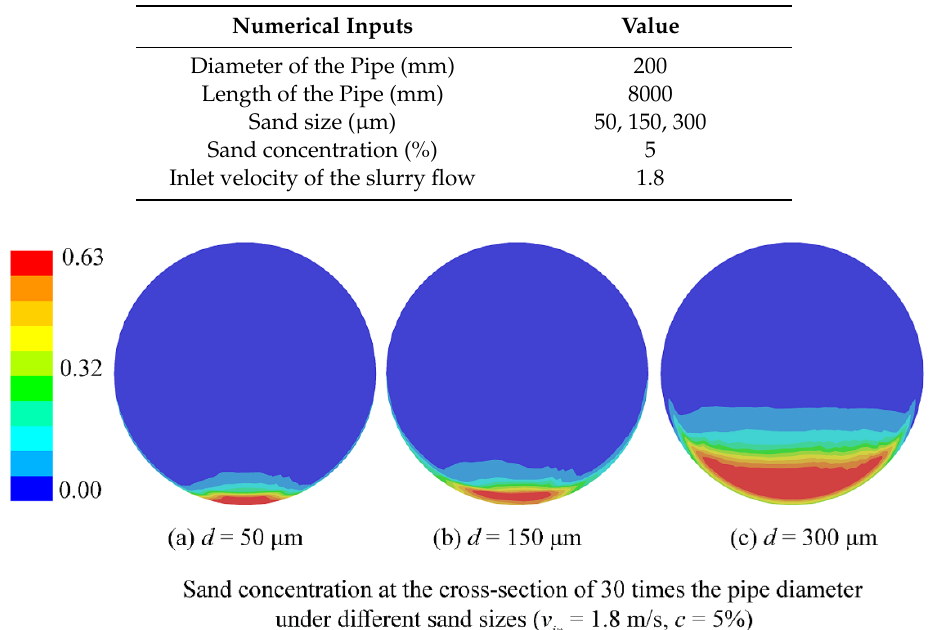
Figure 7. Sand concentration contours at the cross-section of 30 times the pipe diameter under the condition of di ff erent sand sizes ( v in = 1.8 m / s, c =